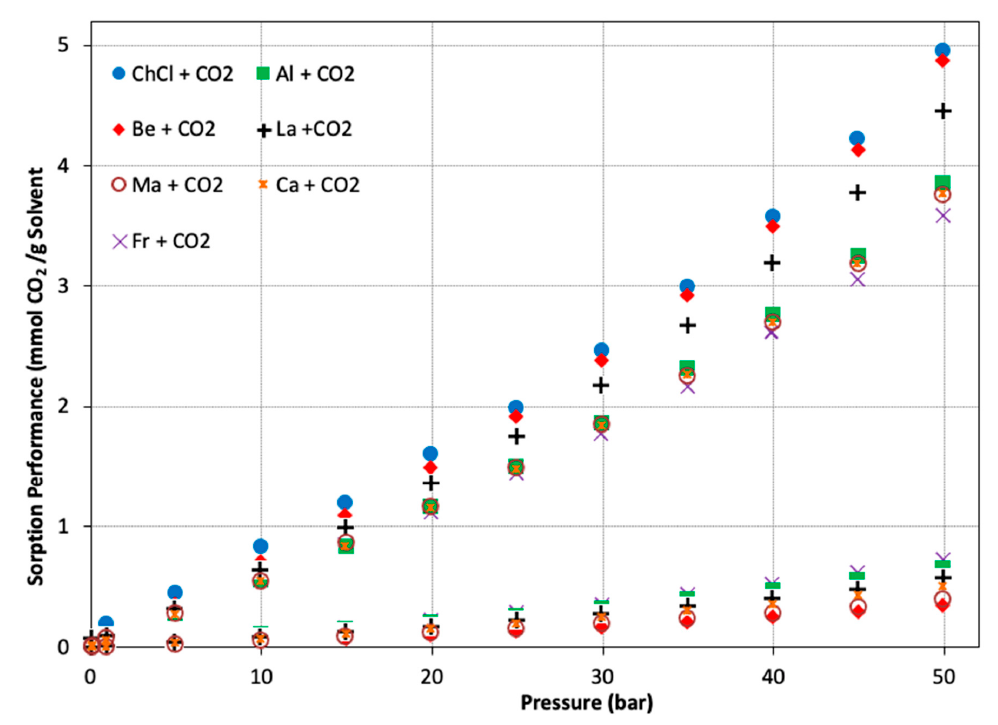
Figure 1. CO 2 capture performance for hydrogen bond acceptors and hydrogen bond donors prior to mixing to form deep eutectic solvent at 298.15 K isotherm.